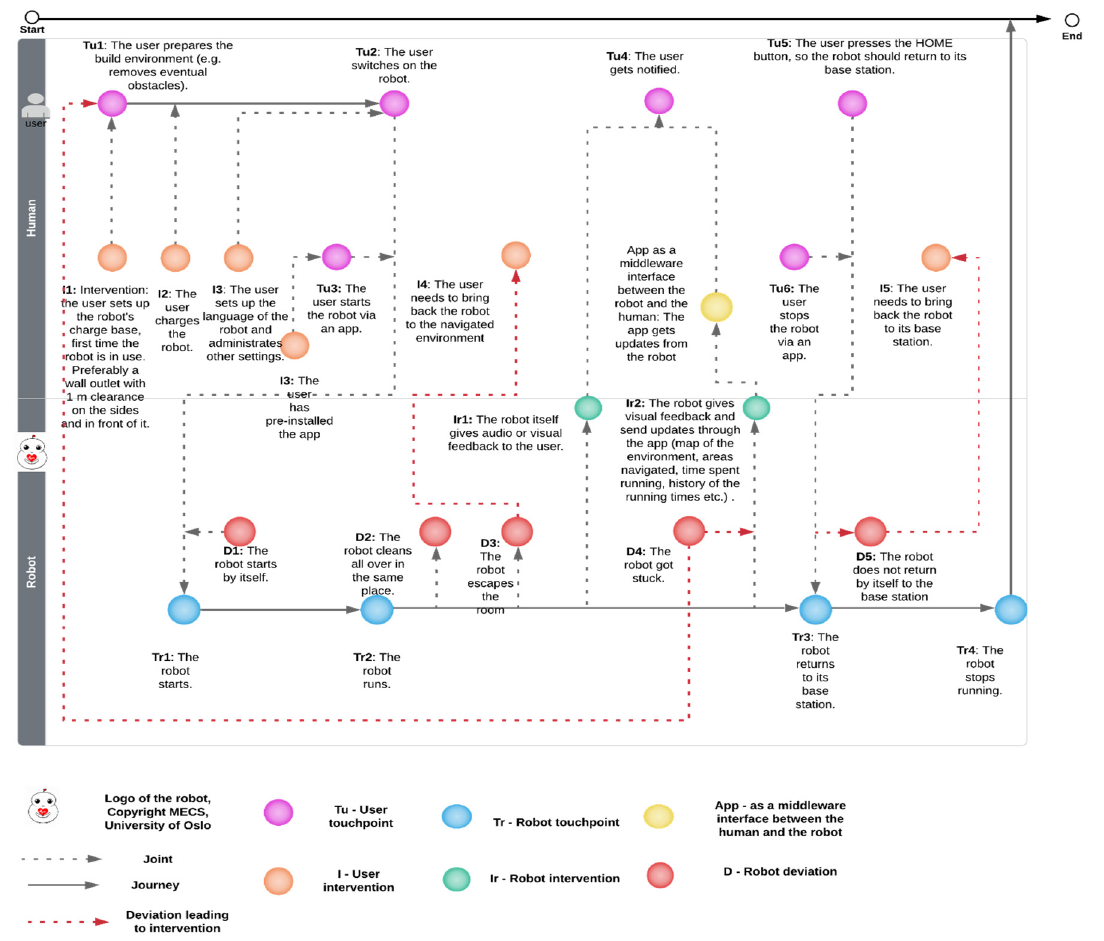
Figure 4. Division of work between human and robot in a vacuum cleaning work activity (Situation 2).